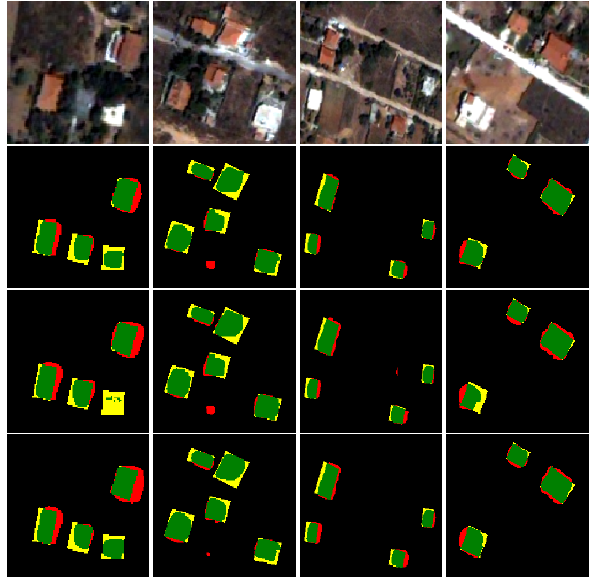
Figure 3. Building predictions on testing areas of Attica VHR dataset for the year of 2006. 1st row: RGB images, 2nd row: multi-task FC-Siam-Conc with 5 dates, 3rd row: multi-task FC- Siam-Diff with 2 dates, 4th row: multi-task L-UNet with 5 dates. [ Green : True Positives, Black : True Negatives, Red : False Posit- ives, Yellow : False